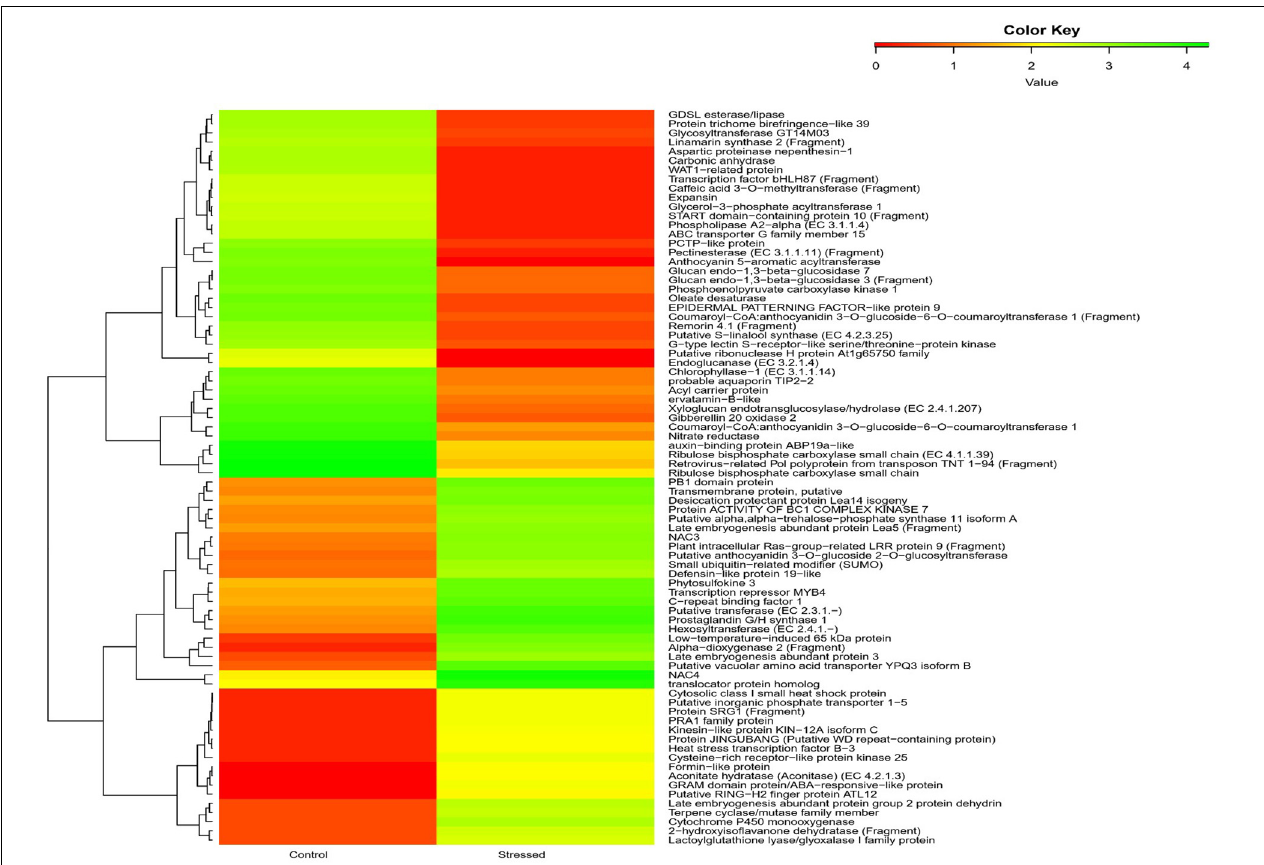
FIGURE 3 | Heatmap shows the top 40 upregulated and downregulated genes of cluster bean cultivar RGC-1025 under control and drought